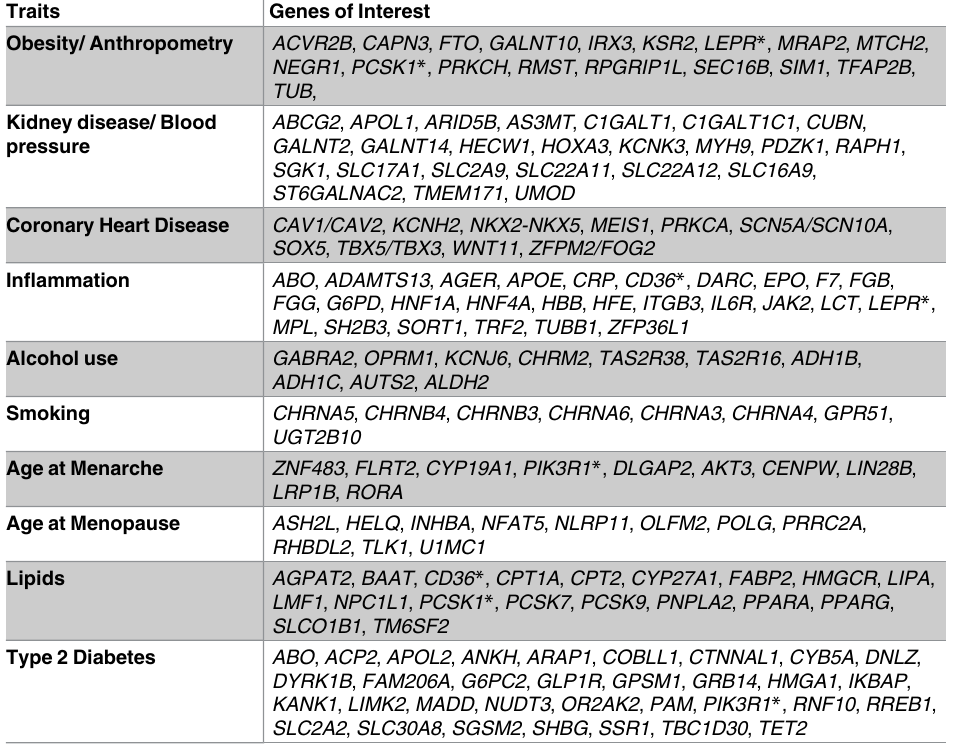
Table 2. List of Prioritized Genes by